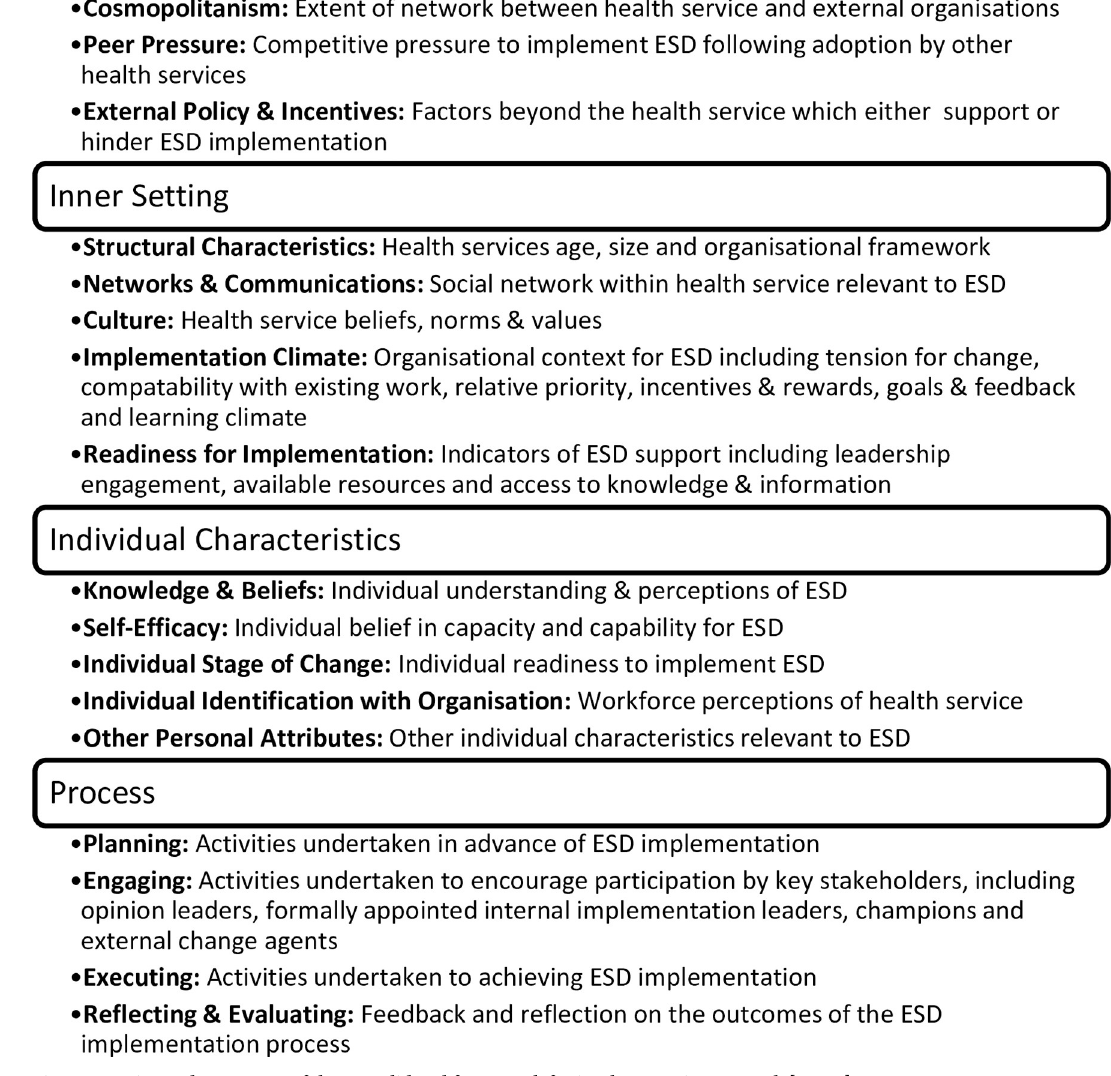
Fig 1. Domains and constructs of the consolidated framework for implementation research [19, 20]. https://doi.org/10.1371/journal.pone.0235055.g001 PLOS ONE | https://doi.org/10.1371/journal.pone.0235055 June 24,